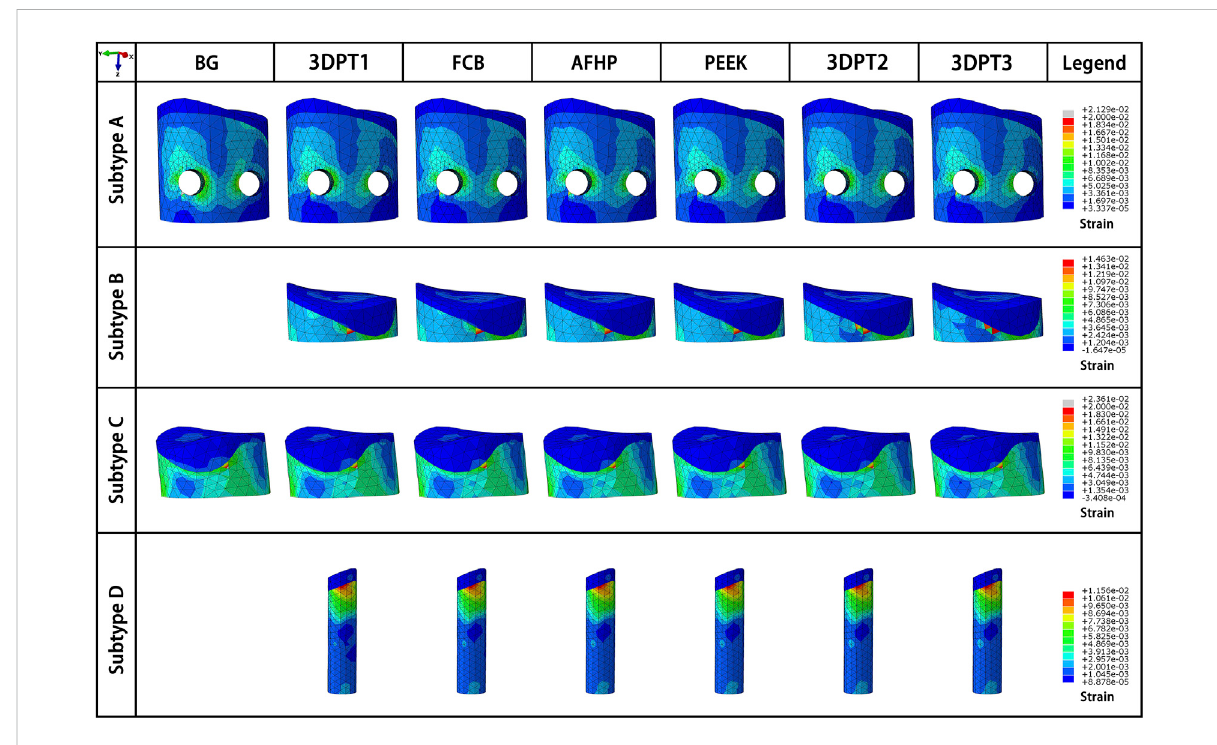
FIGURE 7 Strain fi elds of the depressed fragment from the perspective of maximum strain of the corresponding